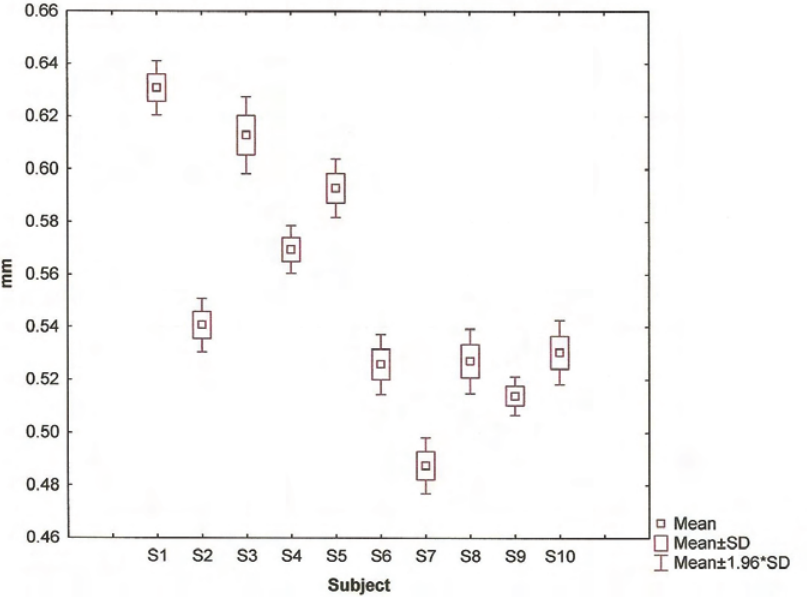
Figure 2. The box and whisker plots for central corneal thickness (CCT) measurements in millimeters ( y -axis) for the right eyes of the 10 subjects. The labels (S1 to S10) on the x -axis are the subject numbers.